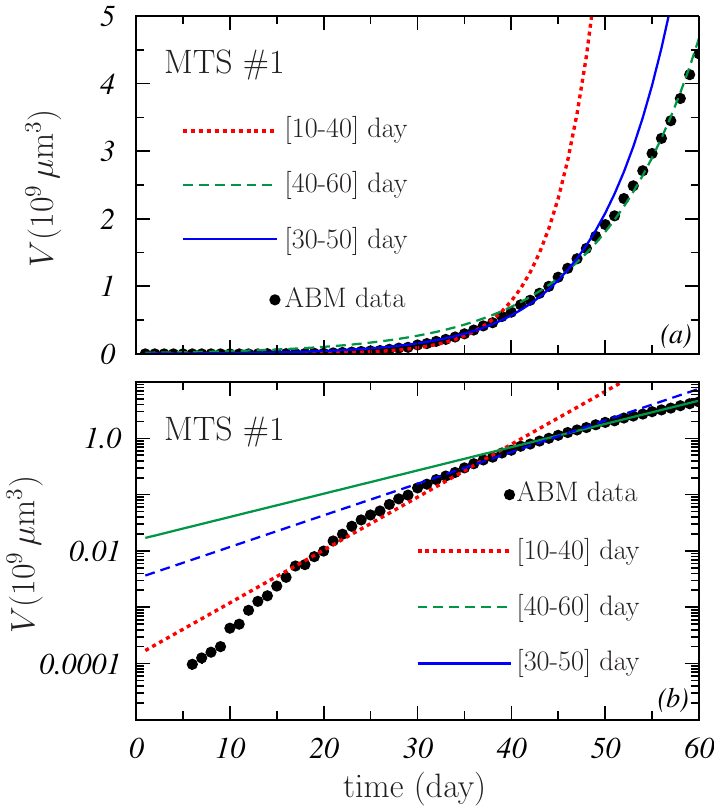
Figure 3. In ( a ), the fits of the exponential model to the simulated ABM data of the MTS #1 of sample #1 are shown. Solid black circles indicate the volumes of this spheroid along the whole time period studied. Dotted red, dashed green, and solid blue lines display the results obtained when the fit involves the data in the time intervals [10–40] day, [40–60] day, and [30–50] day, respectively; ( b ) shows the corresponding semi-logarithmic plot to emphasize the MTS volume